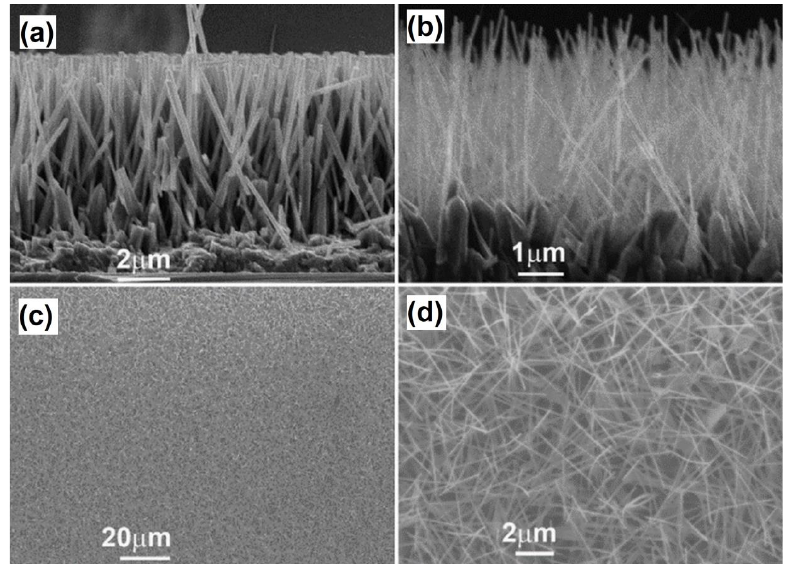
Figure 11. SEM images of the cross section of ZnO nanowire arrays at ( a ) 2 µ m, ( b ) 1 µ m, ( c ) 20 µ m and ( d ) the zoom-in view image of ZnO nanowires at 2 µ m. Reproduced with permission from